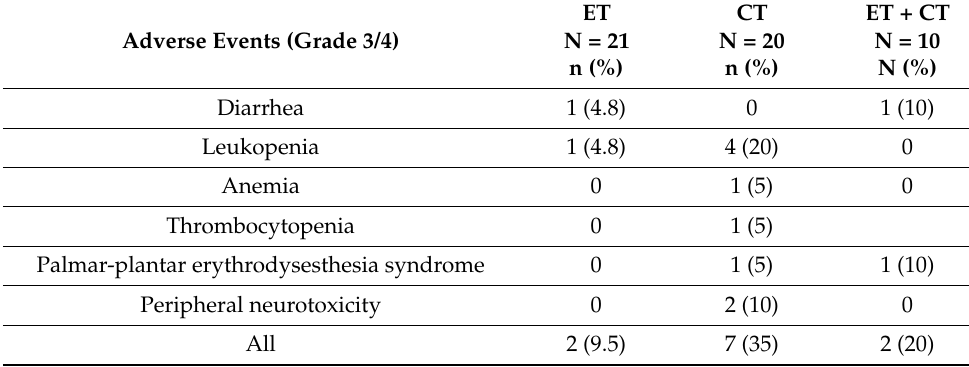
Table 2. Adverse events (grade 3/4).